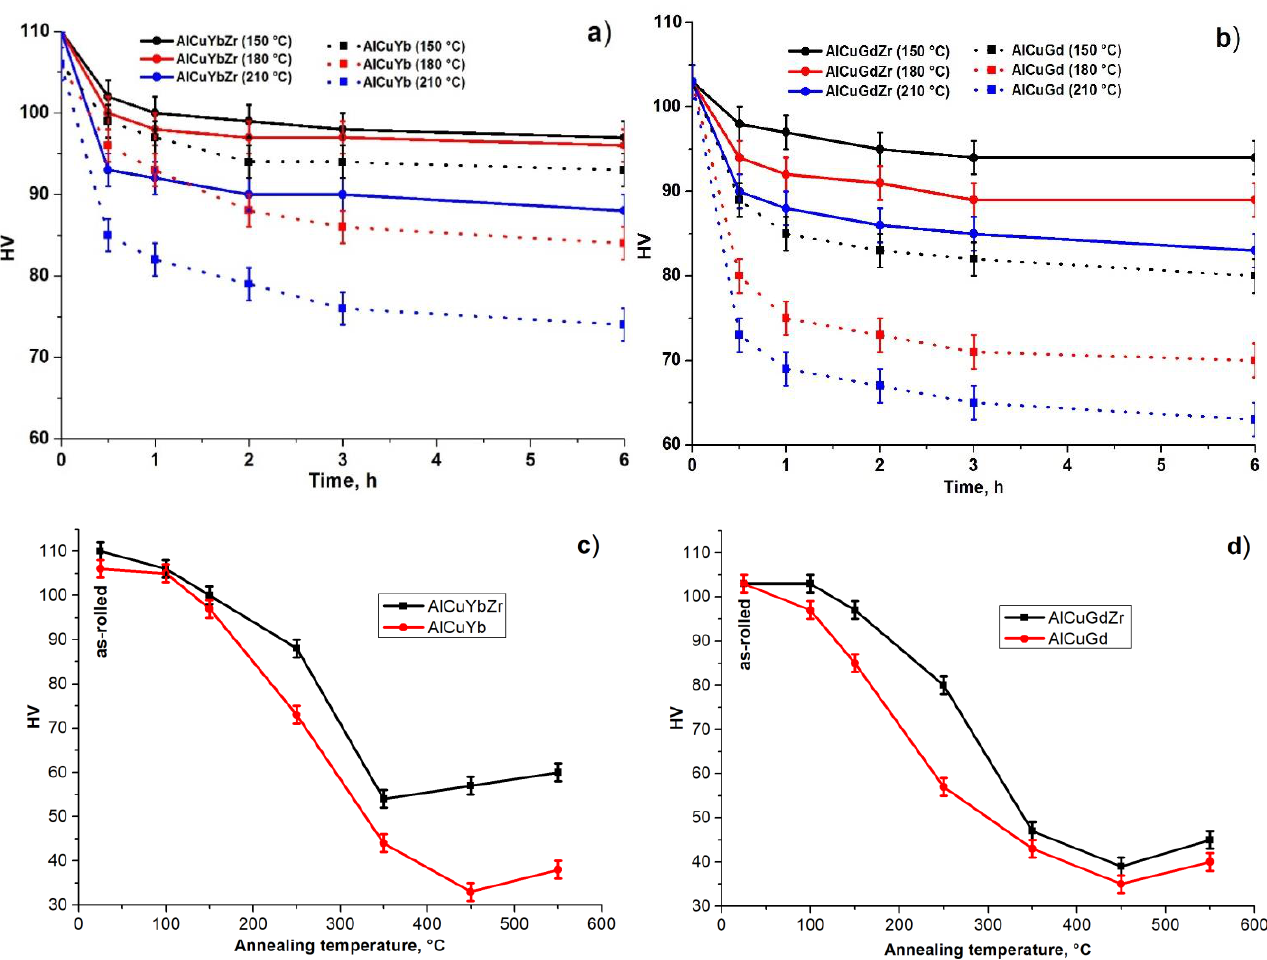
Figure 8. HV vs. time ( a , b ) and annealing temperature (1 h) ( c , d ) dependencies of the rolled AlCuYb/AlCuYbZr ( a , c ) and AlCuGd/AlCuGdZr ( b , d ). Table 2. Tensile properties of the AlCuYbZr and AlCuGdZr alloys in the as rolled and annealed states in comparison with Zr-free